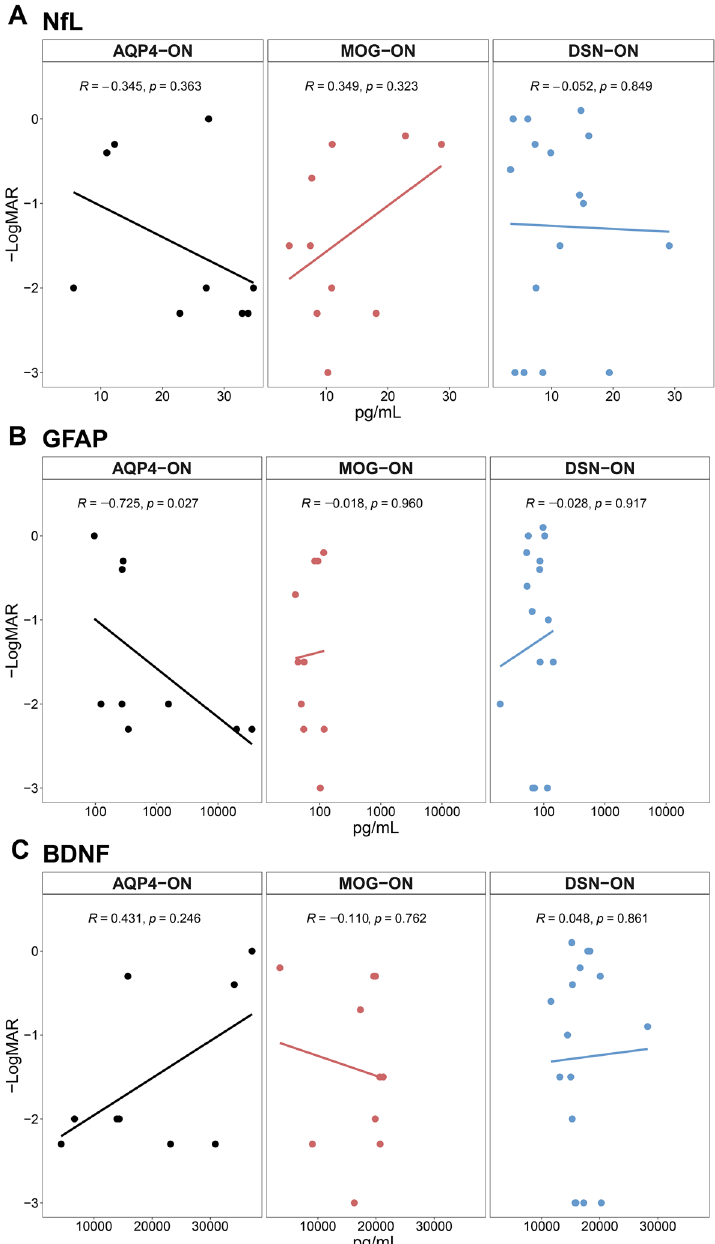
Figure 2. Correlation analyses between visual acuity at attack state and baseline serum biomarkers in patients with AQP4-ON, MOG-ON, and DSN-ON. Correlation between visual acuity (− Logarithm of the Minimum Angle of Resolution) at attack state and serum biomarkers levels at baseline for serum ( A ) NfL, ( B ) GFAP, and ( C ) BDNF in patients with ON. AQP4-ON optic neuritis with aquaporin-4 antibody, BNDF brain-derived natriuretic factor, DSN-ON double-seronegative optic neuritis, GFAP glial fibrillary acidic protein, MOG-ON optic neuritis with myelin oligodendrocyte glycoprotein antibody, NfL neurofilament light chain, ON optic